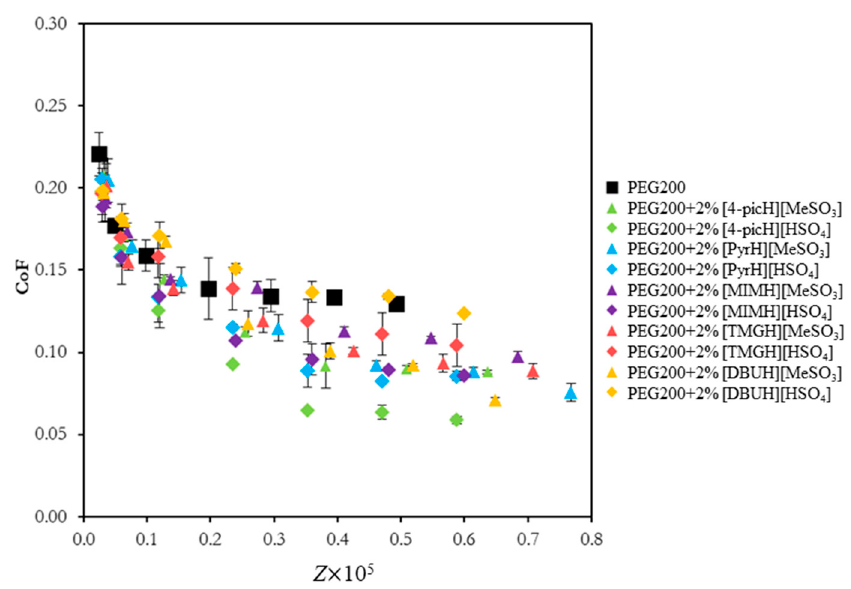
Figure 2. CoF vs. Sommerfeld parameter, Z , for the pair SS sphere/Si substrate using neat PEG200 Figure 2. CoF vs . Sommerfeld parameter, 𝑍 , for the pair SS sphere/Si substrate using neat PEG200 and the mixtures PEG200 + 2% PIL as lubricants. The errors are ± standard deviation (n ≥ and the mixtures PEG200 + 2% PIL as lubricants. The errors are ±standard deviation (n ≥ 3).